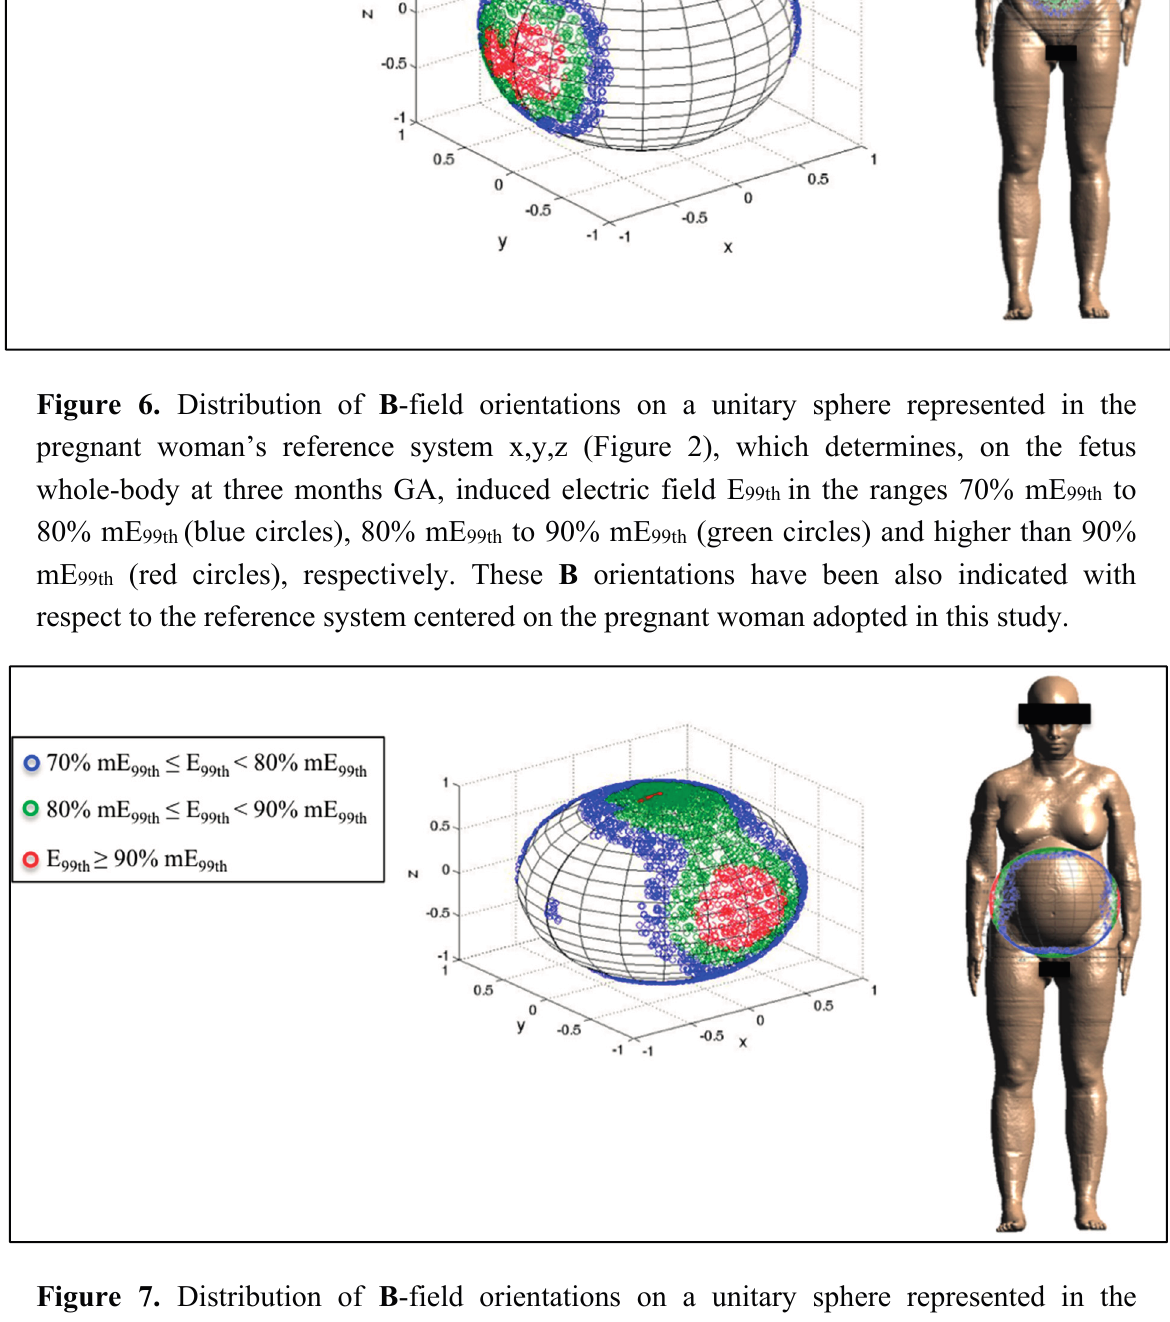
Figure 7. Distribution of B -field orientations on a unitary sphere represented in the pregnant woman’s reference system x,y,z (Figure 2), which determines, on the fetus whole-body at seven months GA, induced electric field E 99th in the ranges explained in Figure 6. The B orientations have been also indicated with respect to the reference system centered on the pregnant woman adopted in this